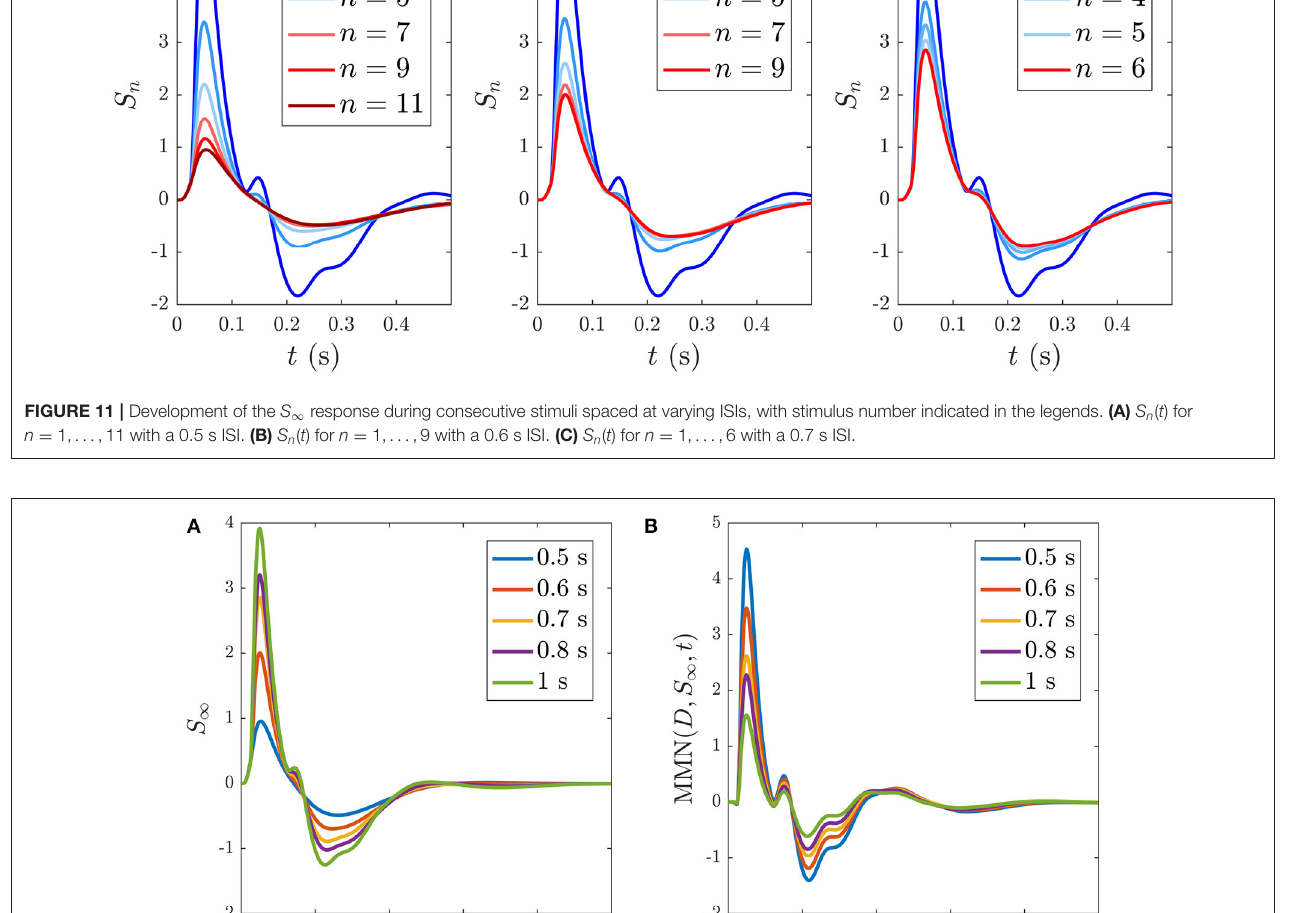
FIGURE 12 | Dependence of S on the ISI, with ISI indicated in the legends. (A) S ∞ corresponding MMN( D , S , t ) for each of the cases in (A) ∞